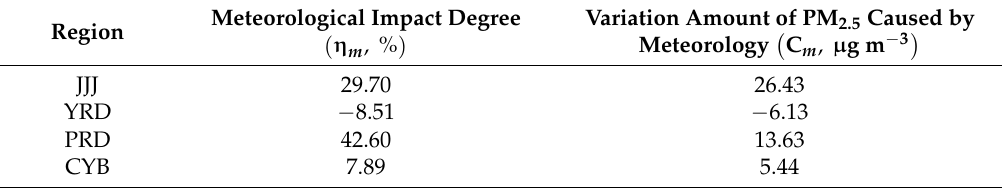
Table 7. Impacts of the meteorological conditions on the PM 2.5 pollution in major